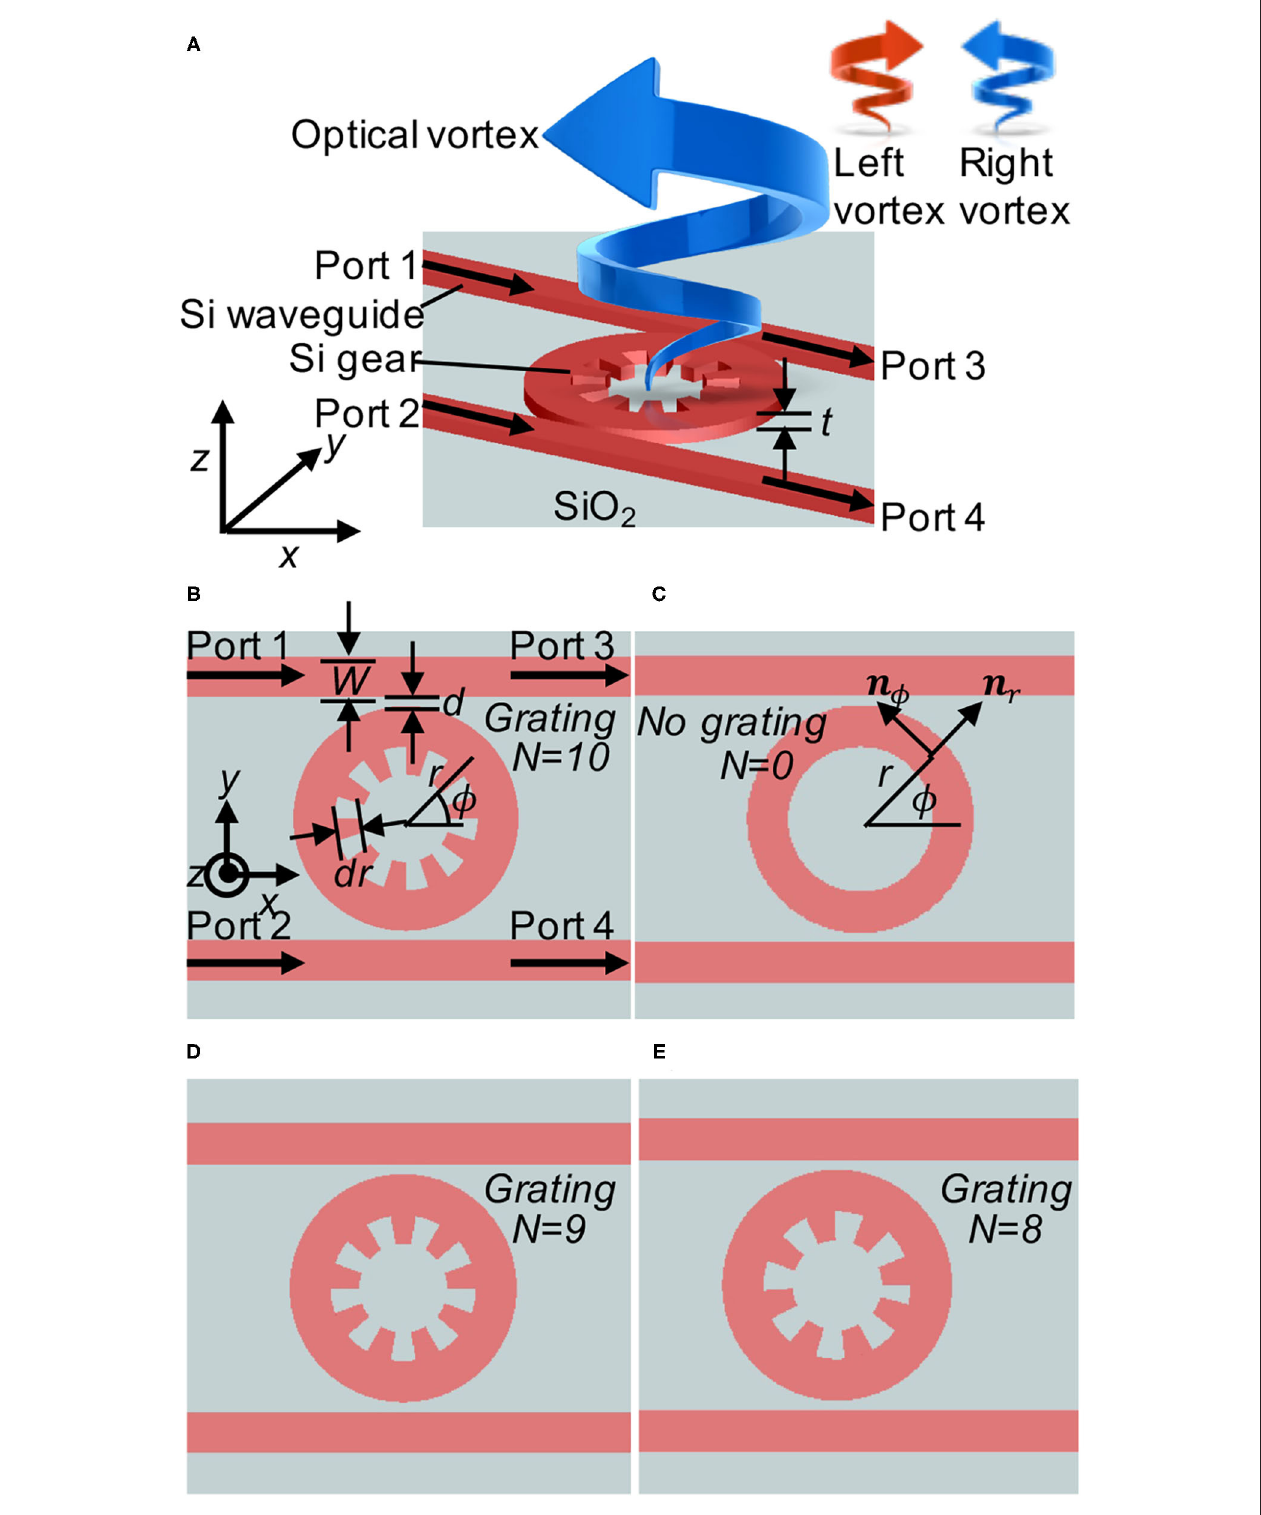
FIGURE 1 | Poincaré rotator. (A) Birds’ view of the proposed device. The silicon (Si) micro-gear is coupled to two Si wire waveguides located on top of silicon dioxide (SiO 2 ). Two input ports (1 and 2) are used to inject photons with certain phases and amplitudes to generate a vortex beam with a superposition state of left and right vortexed states. The thickness of the Si layer is t 220 nm. (B) Gear of the grating number N of 10. The width of waveguide is W = dip is dr 220 nm. The distance of between the gear and the waveguide is d 100 nm. The radius of the grating is 1 µ m. (C) Ring resonator for the reference. Unit = = vectors of n r and n φ are shown. (D) Gears of N 9. (E) Gears of N = =